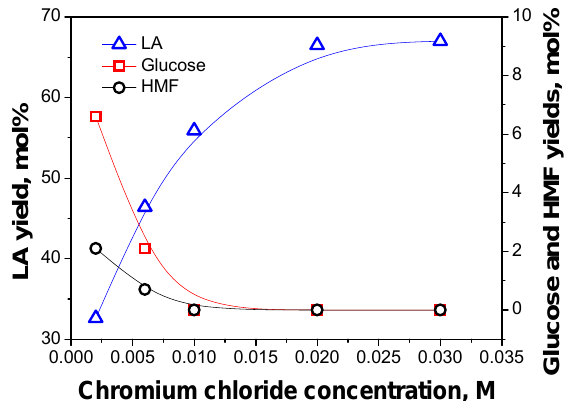
Figure 9. Effect of catalyst dosage on yields of